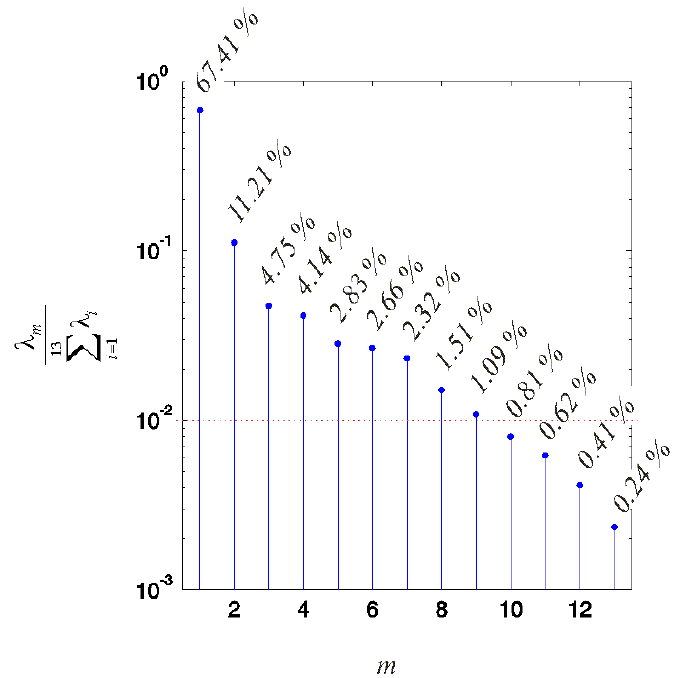
Figure 6. The variance of the acceptable deviations from the desired motion covered with the obtained principal components in logarithmic scale. The last four components each cover less than 1% of the variance. These components, covering 2.08% of the variance, were attributed to noise and/or different artefacts and teased from the first nine components. In sum, the first nine components cover the remaining 97.02% of the variance.